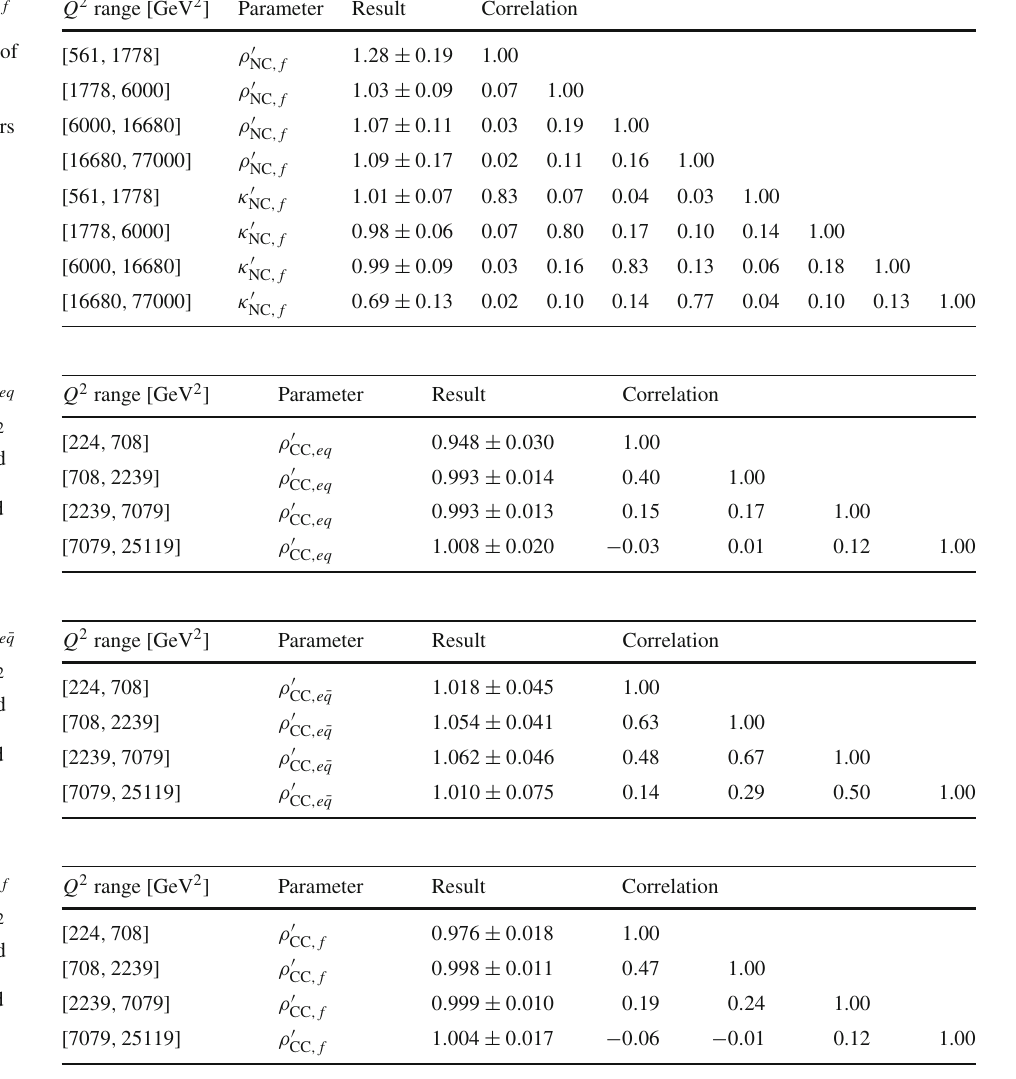
Table 15 Results for the ρ (cid:6) NC , f and κ (cid:6) parameters NC , f determined at different values of Q 2 . The Q 2 range of the data selection, and the correlation coefficients of the fit parameters are indicated